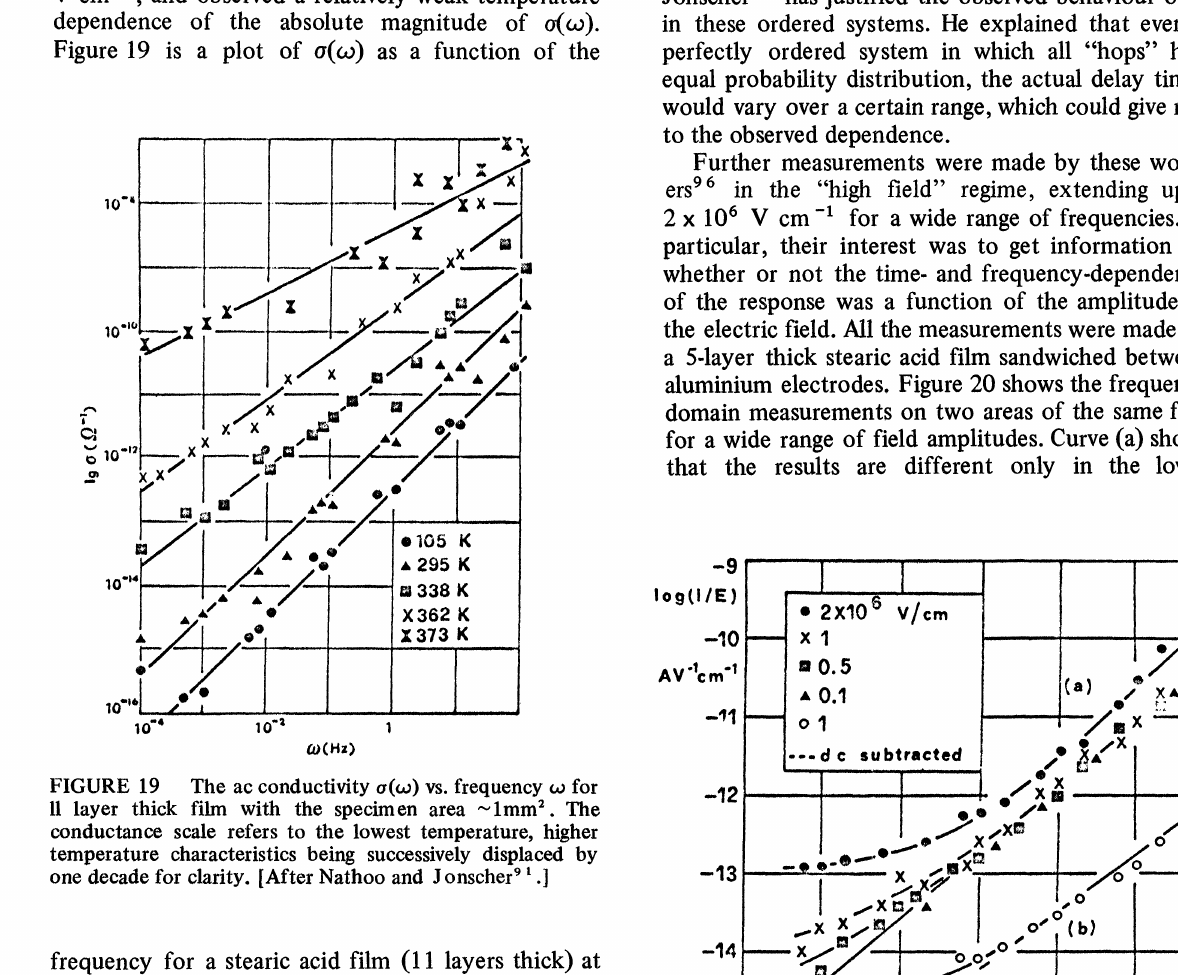
(Hz) Frequency domain measurements on two areas (a) and (b) of the same device, A1-5 layer stearic acid film-A1, for a range of electric fields at room temperature. The dashed line for sample (b) represents the "true ac" data afer deduction of the dc. Data for sample (b) are displaced downwards by two orders of magnitude for clarity. The curves represent log-log plots of (I/E)vs. f where is the current per cm and E is the field in V]cm. [After Jonscher and Nathoo